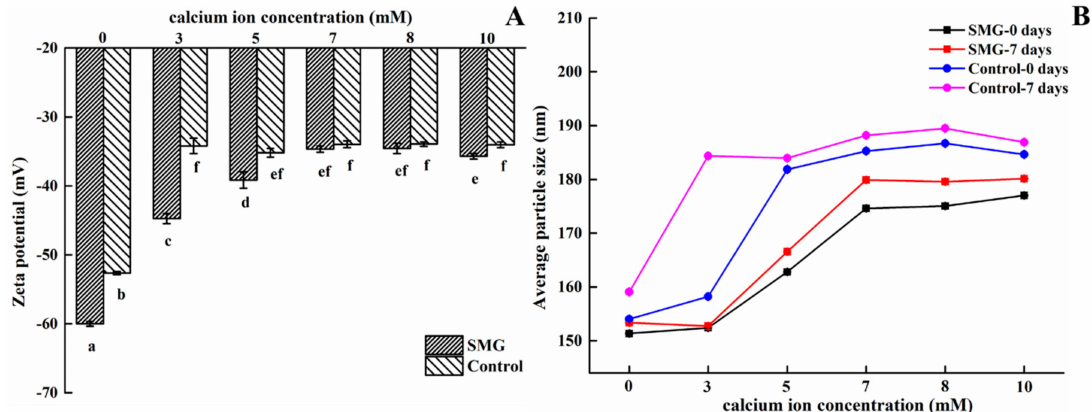
Figure 9. E ff ects of calcium ions on the stability of the SMG-stabilized emulsions. ( A ) Zeta potential of emulsions; ( B ) average particle size of